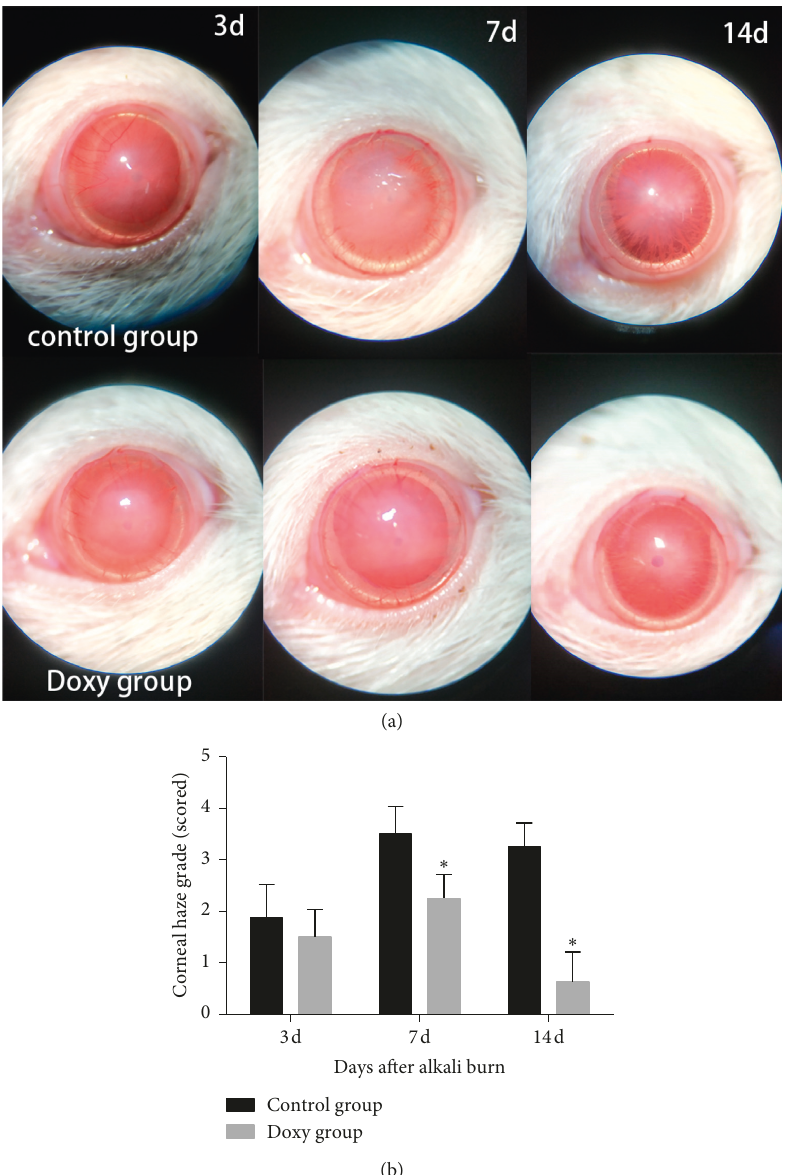
Figure 1: (a) Slit-lamp photographs of corneas in the doxycycline group and the control group on days 3, 7, and 14 after corneal alkali burn. (b) Corneal opacity scores of two groups on the 3rd, 7th, and 14th day. The doxycycline group had a significant lower score than the control group 7 and 14 days after chemical injury ( P < 0 . 05). ∗ Statistically significant; data are expressed as mean ± SD, n �